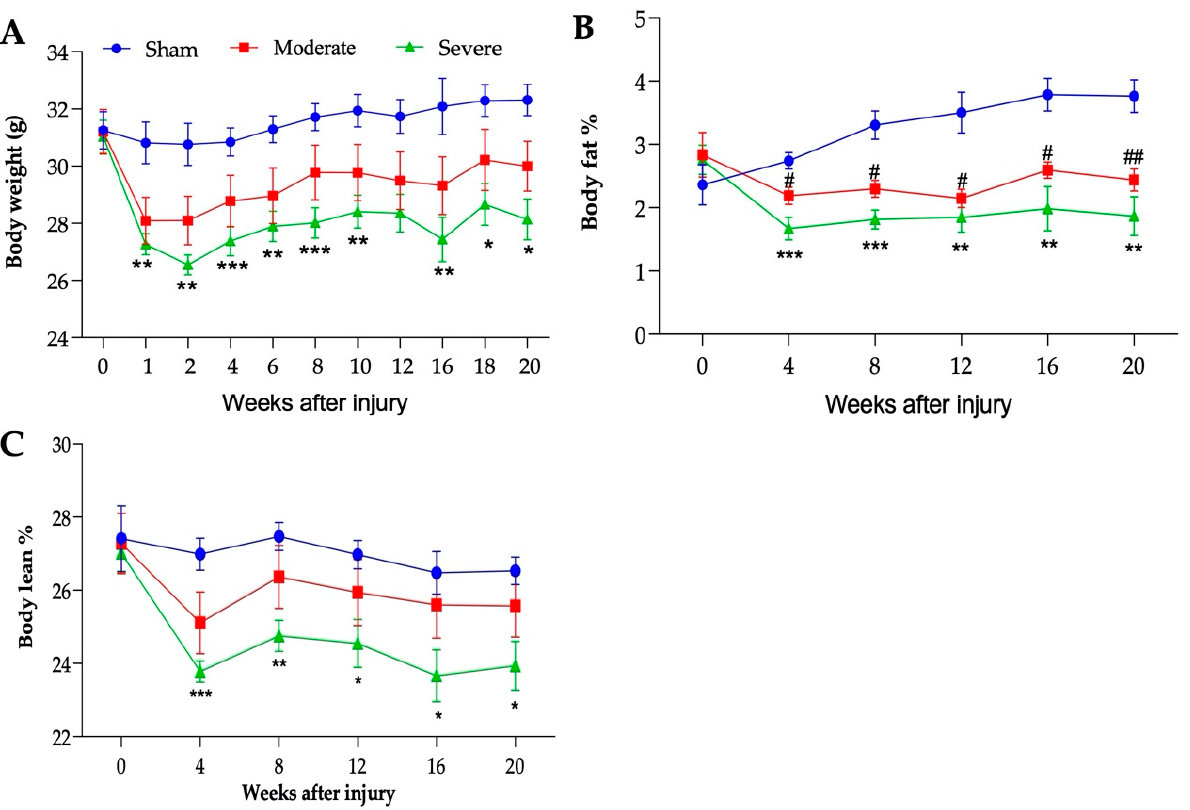
Figure 3. Injury-severity dependent body composition changes. ( A ) Body weight (g), ( B ) percent- age of body fat, and ( C ) percentage of lean body mass. Statistical analysis was performed using repeated measures two-way ANOVA; Tukey’s multiple comparisons test was used to determine the differences between the groups. Data presented as mean ± SEM, n = 6 (sham), 8 (moderate), and 5–9 (severe). * p ≤ 0.03, ** p ≤ 0.002, *** p ≤ 0.001 difference between sham and severe groups and # p ≤ 0.03, ## p ≤ 0.002 difference between sham and moderate groups.